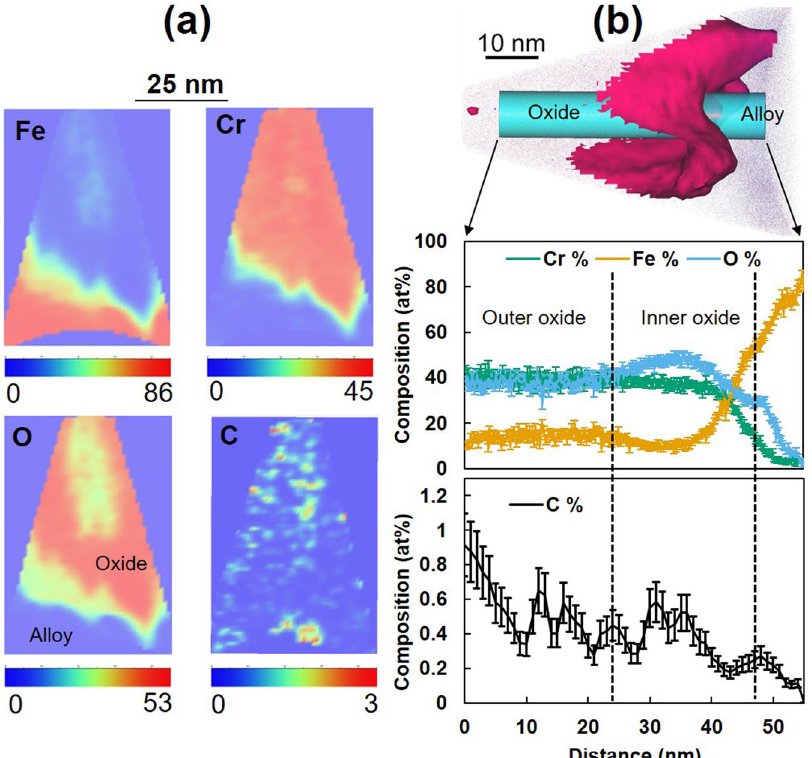
Fig. 6 APT analysis of Fe22Cr after AP-XPS in high purity CO 2 . a Two-dimensional atomic composition maps showing a 10-nm slice of an APT specimen that captured the oxide layer and underlying alloy. b One-dimensional compositional pro fi le corresponding to a 10 nm diameter cylindrical region of interest across the oxide/alloy interface. Error bars represent the standard counting error as described in the “ Methods ”